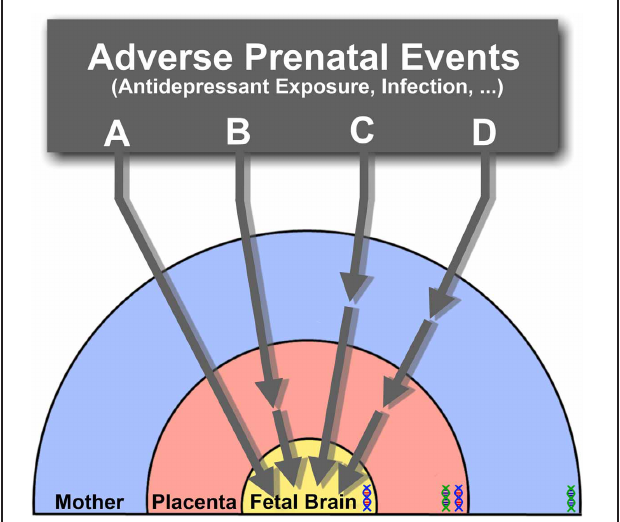
FIGURE 2 | The effects of SSRIs on fetal brain development may be through direct (A) or indirect pathways that affect placental (B), maternal (C), or both maternal and placental physiology (D), ultimately resulting in downstream effects on the fetus. Direct effects (A) suggest that SSRIs readily cross the placenta and enter the fetal circulation, where they would directly target the developing brain’s serotonergic system. Alternatively, physiological changes in the placenta (B) , or delivery of maternal factors essential for the developing fetal brain (C) may be affected through indirect pathways. The combination of both direct and indirect pathways inducing adverse effects on the fetal brain may also be possible (D) . Under the influence of varying s maternal, fetal and placental (maternal-fetal combination) genetic susceptibilities (DNA double helix), the effects of SSRI exposure at different pregnancy stages may lead to diverse developmental